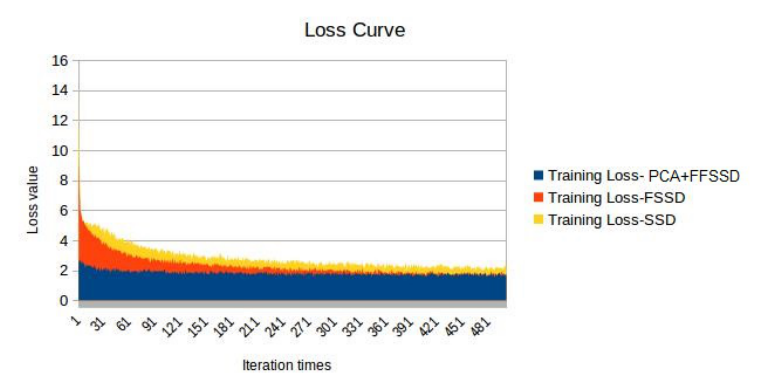
Figure 10. Loss curve transformation during SSD, FSSD, and FFSSD training (a total of 5000 training times).